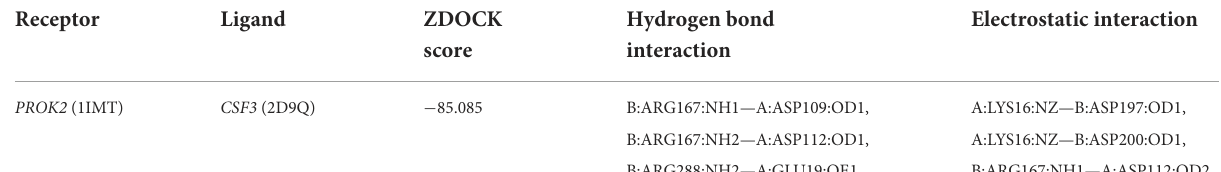
TABLE 1 Results of molecular docking vina, discovery studio 2019. Receptor